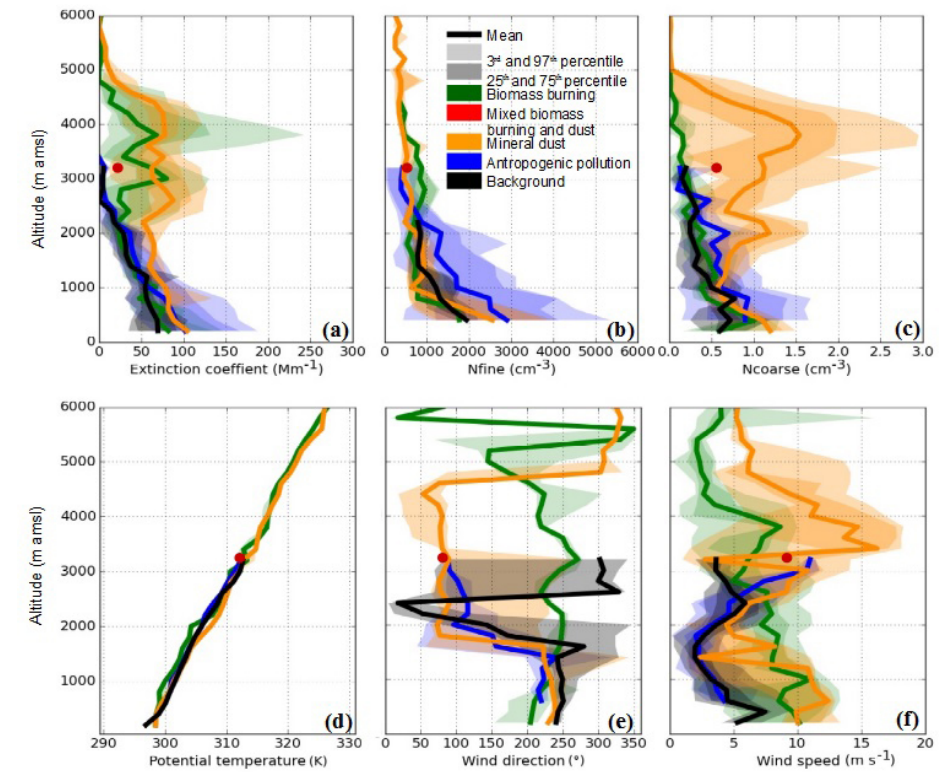
Figure 4. Vertical layering of aerosols and meteorological variables for profiles for which aerosols dominated by biomass burning (green), dust (orange), mixed dust–biomass burning (red), anthropogenic pollution (blue) and background particles (black) were detected. The panels show profiles of (a) the extinction coefficient at 530nm, (b) the particle number concentration in the range 0 . 005 < D p < 1µm, (c) the particle number concentration in the range 1 < D p < 5µm, (d) potential temperature, (e) the wind direction and (f) the wind speed. The coloured areas represent the 3rd, 25th, 75th and 97th percentiles of the data. The mixed dust–biomass burning plume is represented by a dot because it is derived from measurements during a SLR.